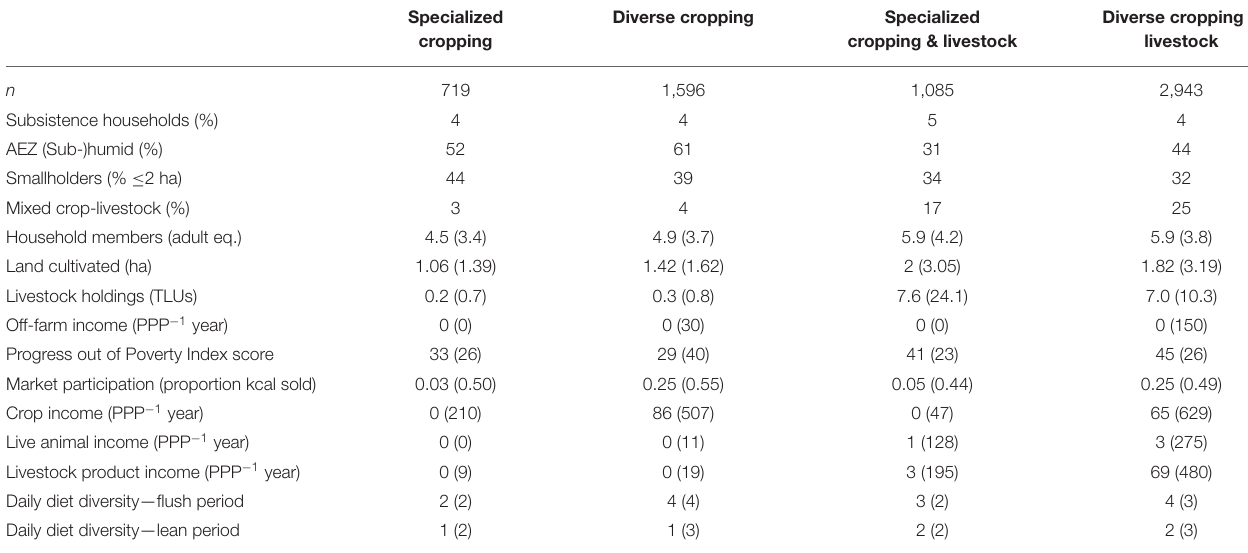
TABLE 3 | Summary of resources, income, and diet diversity of sampled households by farm type (number, proportion and median-IQR).